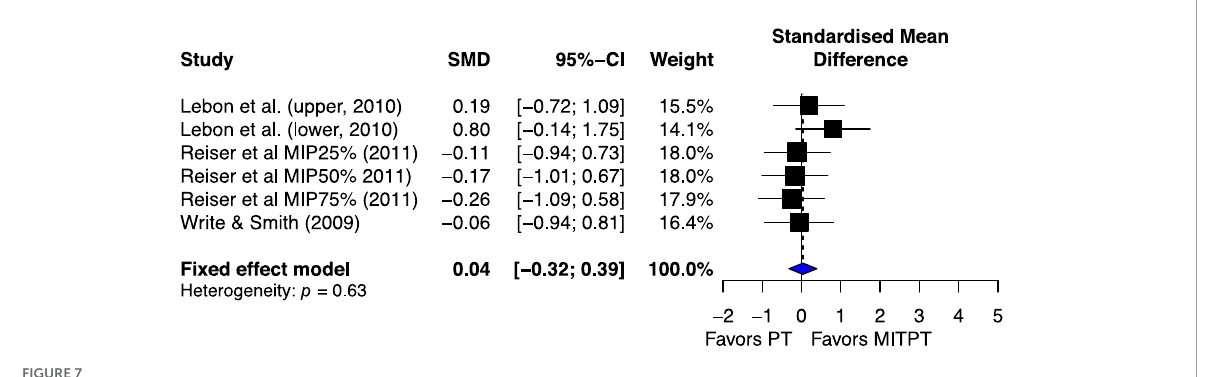
FIGURE6 Effects on maximal muscle strength: Mental imagery training (MIT) vs. physical training (PT).